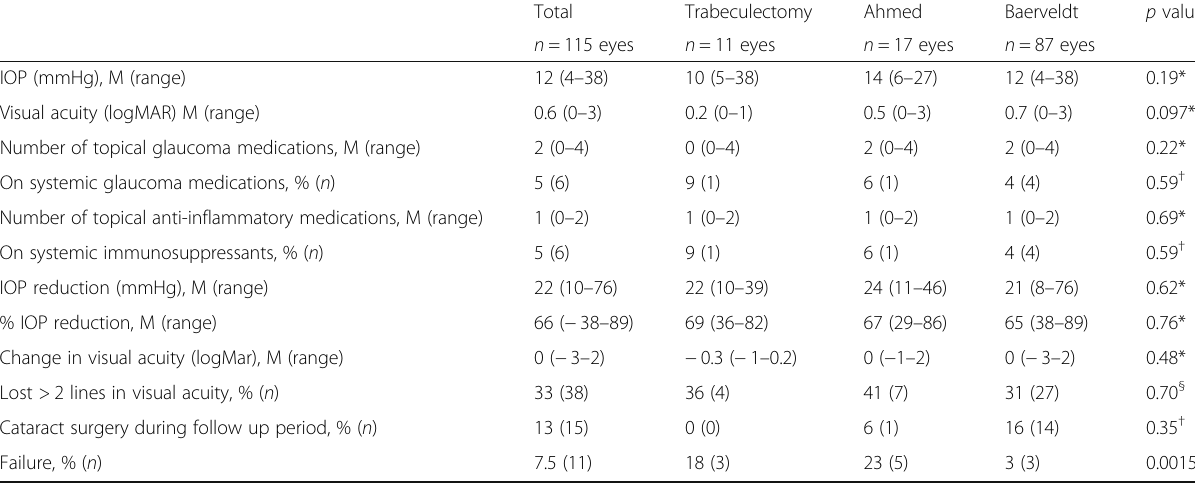
Table 3 Twelve-month postoperative outcome